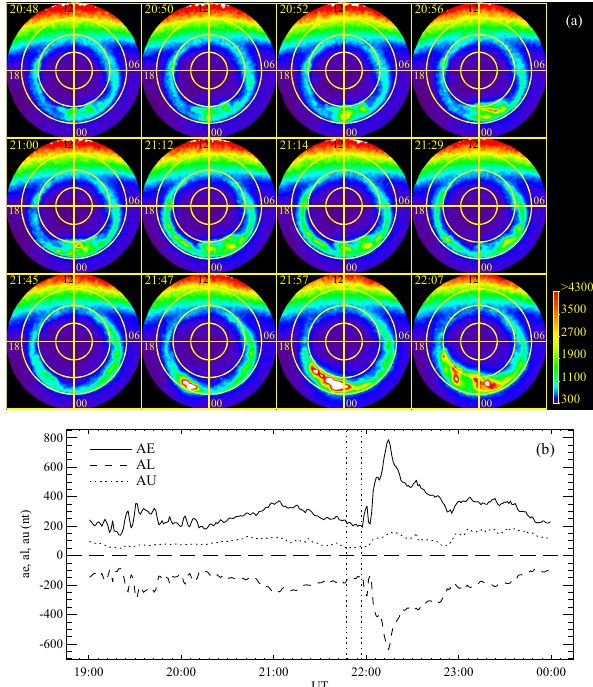
Fig. 6. (a) Polar view of the WIC count rate obtained on 7 Decem- ber 2000, in magnetic coordinates (noon at top, concentric circles every 10 Deg MLAT). (b) Auroral AE, AL and AU indices recorded on 7 December 2000. The vertical dotted lines indicate the auroral brightenings observed at 21:47 and